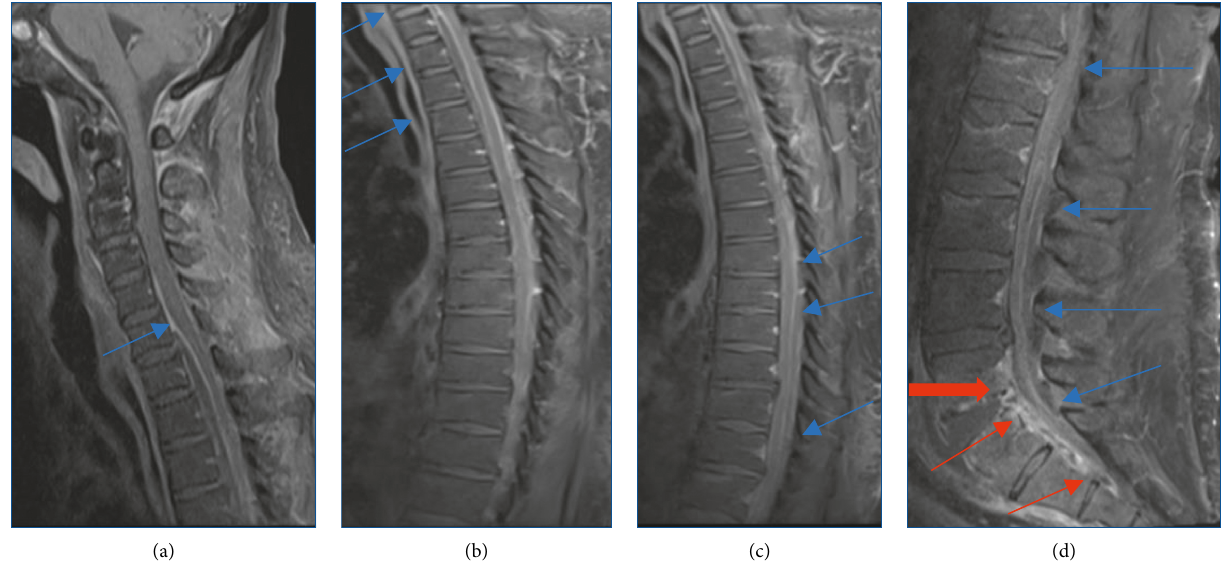
Figure 1: T1-weighted MRI scans: (a) anterior epidural rim enhancing collection extending from C6-T4 (below the image field). The starting point of the abscess is marked by a blue arrow. There is posterior displacement of the spinal cord with significant narrowing of the spinal canal. (b) Extension of the anterior epidural abscess from the cervical spine to the T4 level (blues arrows). There is a mass effect and flattening of an anterior aspect of the spinal cord. (c) Posterior epidural minimally enhancing collection extending from T7-T8 level to L5-S1. (d) The poster epidural collection extending from the thoracic spine to L5-S1 (blue arrows). L5-S1 osteomyelitis-discitis (thick red arrow) and anterior epidural abscess extending from the same level to the lower